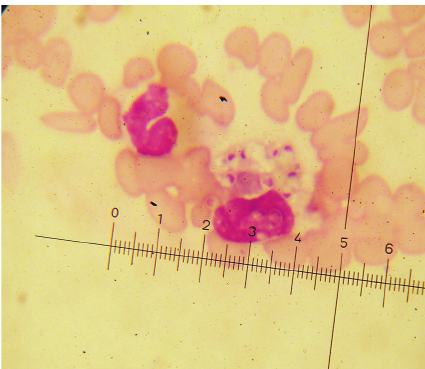
Figure 2: MGG peripheral blood film ( × 100); Histoplasma capsu- latum inside and next to a monocyte.